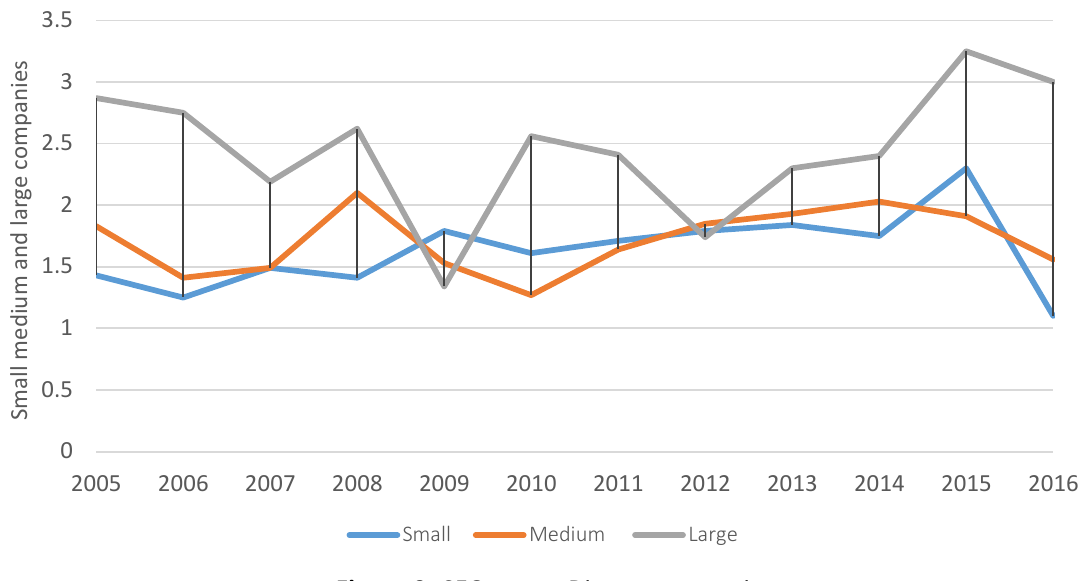
Figure 9. CEO pay to Director pay